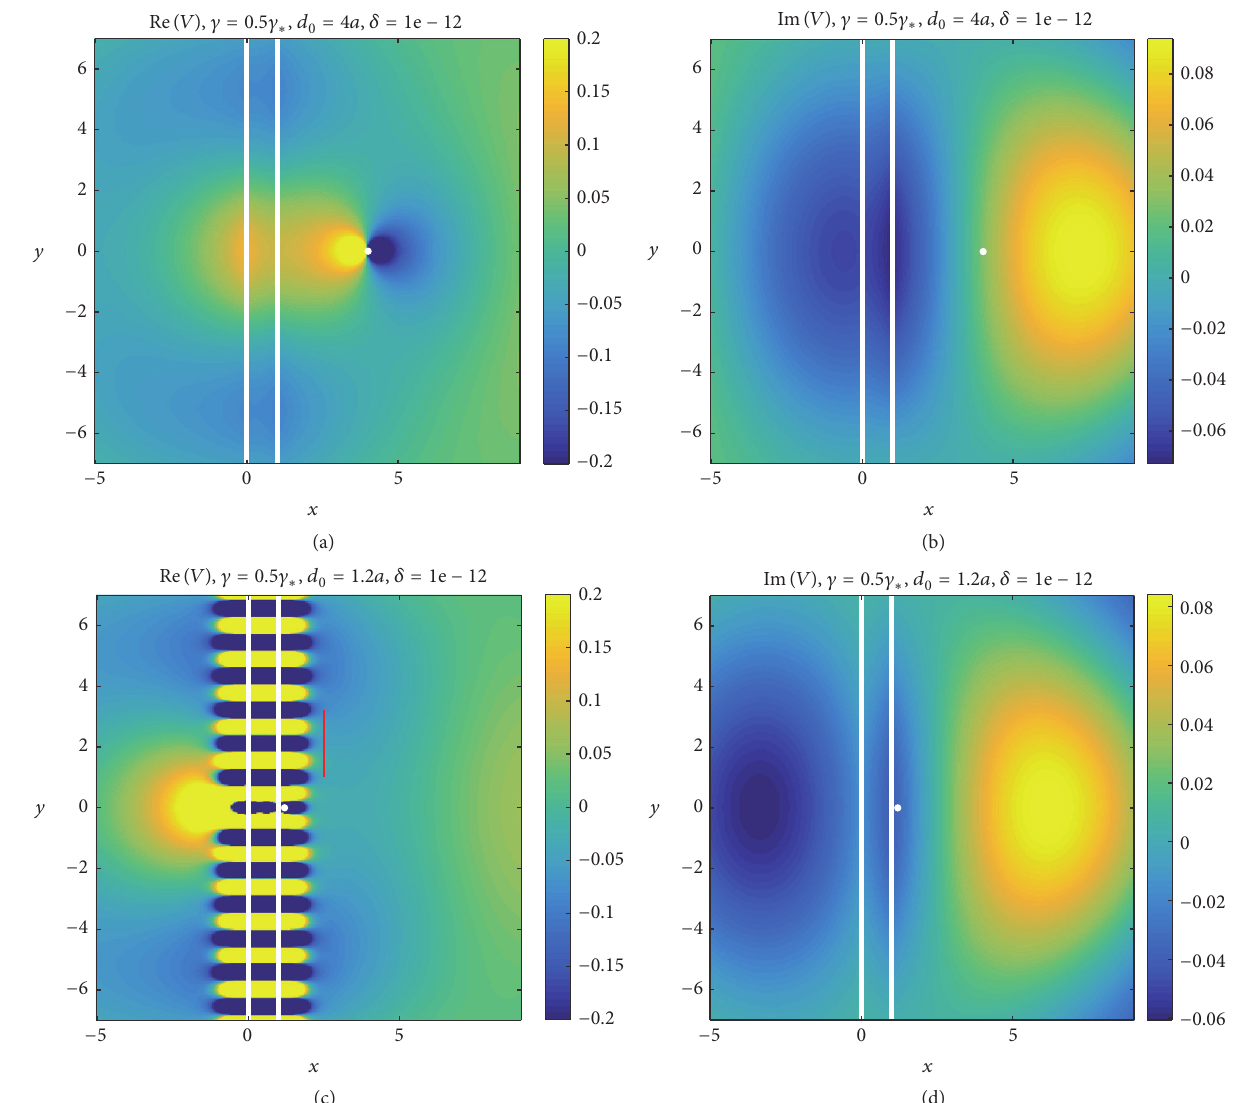
Figure 7: This is a plot of 𝑉 , the solution to (4), when 𝑓 is a dipole and 𝛾 = 0.5𝛾 ∗ : (a) Re (𝑉) and (b) Im (𝑉) for 𝑑 0 = 4𝑎 ; (c) Re (𝑉) and (d) Im (𝑉) for 𝑑 0 = 1.2𝑎 . To make the behavior of 𝑉 clearer, we clipped the maximum and minimum values in each plot to 0.2 (yellow) and −0.2 (blue), respectively. The vertical red line in (c) extends a distance of 2𝜆 𝛾 , where 𝜆 𝛾 is defined in